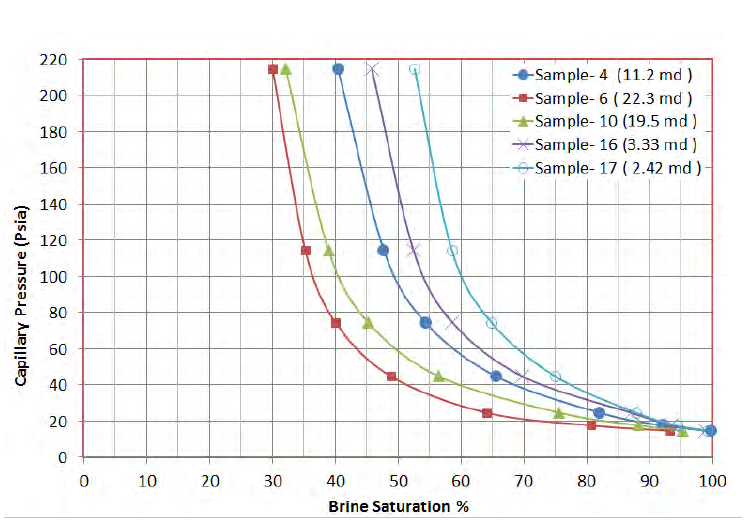
Figure 12. Samples capillary pressure for Upper Bahariya reservoir